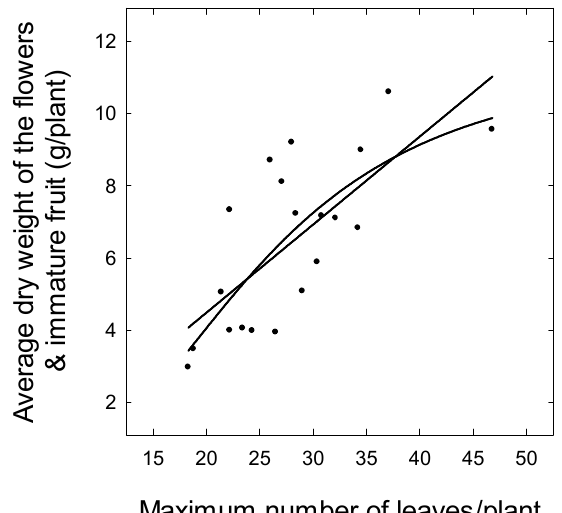
Figure 3. Relationships between average dry weight of the flowers and immature fruit (potential yield, DW) and maximum number of leaves/plant (No. leaves) in strawberries in Queensland. Data are the means of two to six replicates (mostly four) per treatment. Linear and dose-logistic models shown. DW = − 0.38 + 0.24 × No. leaves ( R 2 = 0.49, n = 20). DW = 11.57/{1 + exp. [2.79 (No. leaves − 24.92)]} ( R 2 = 0.50, n = 20).